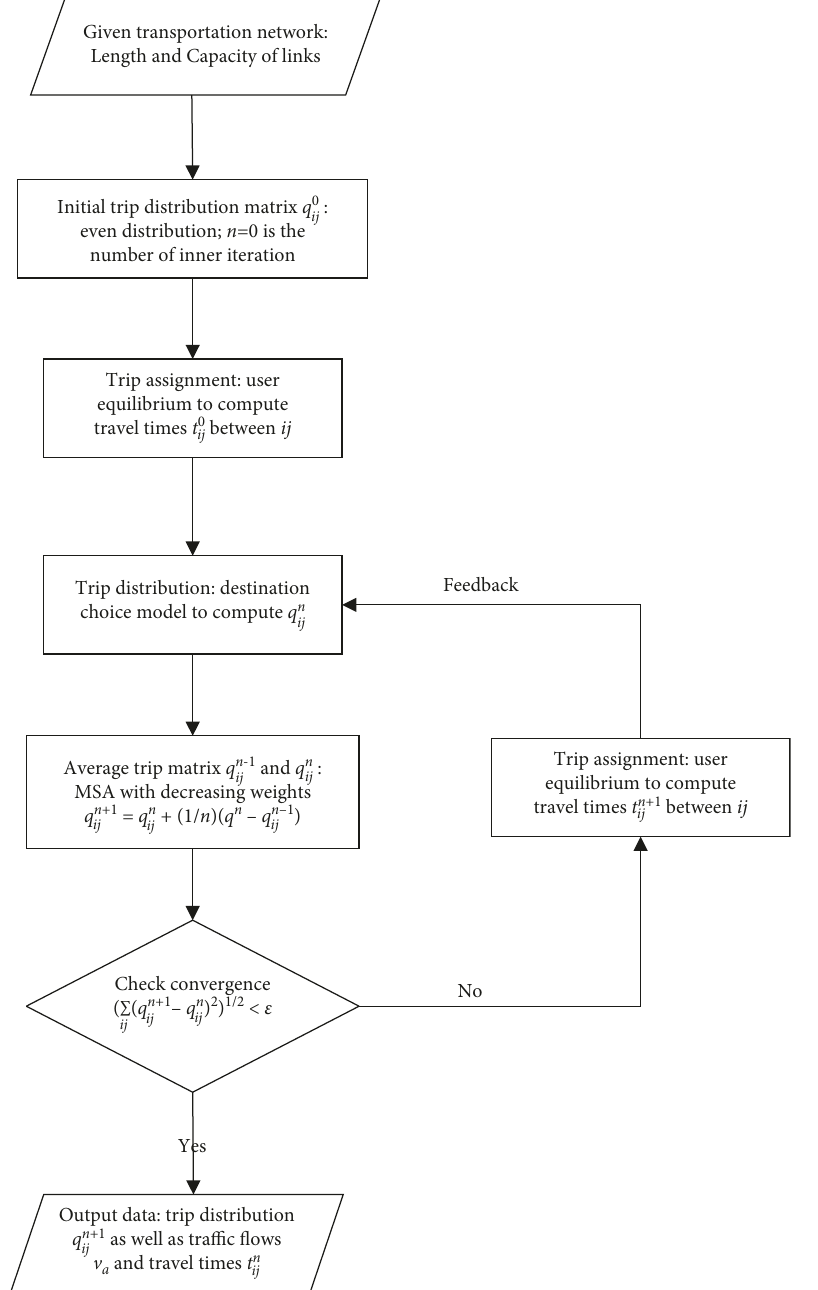
Figure 2: Algorithm flowchart for transportation system